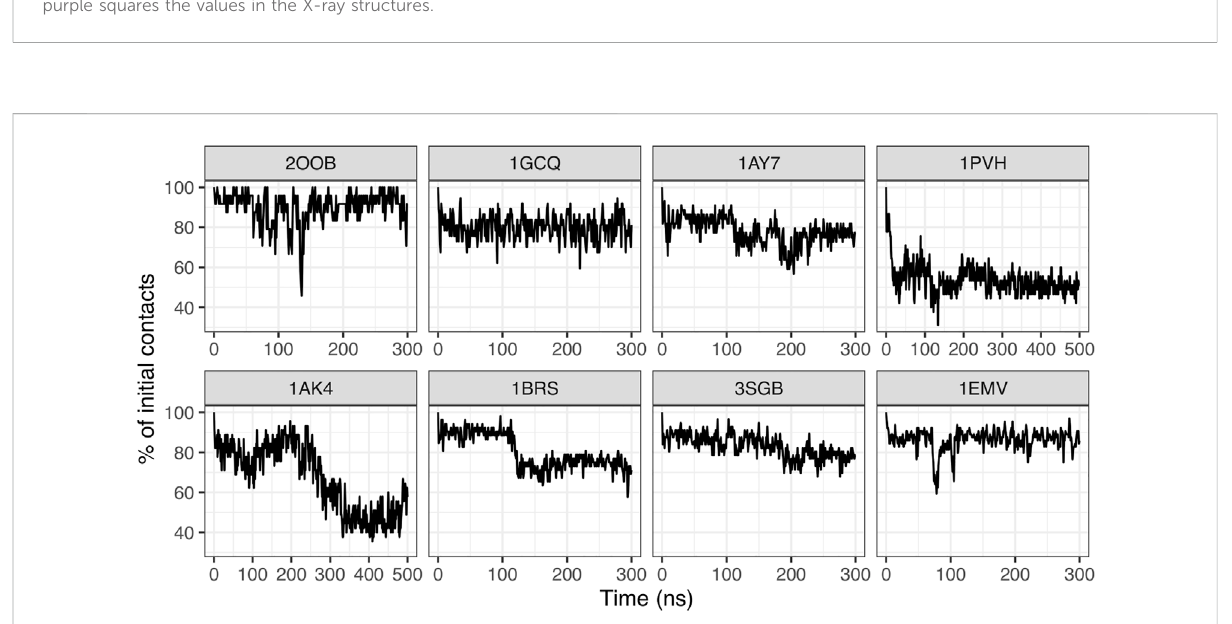
Time series of the conservation of initial